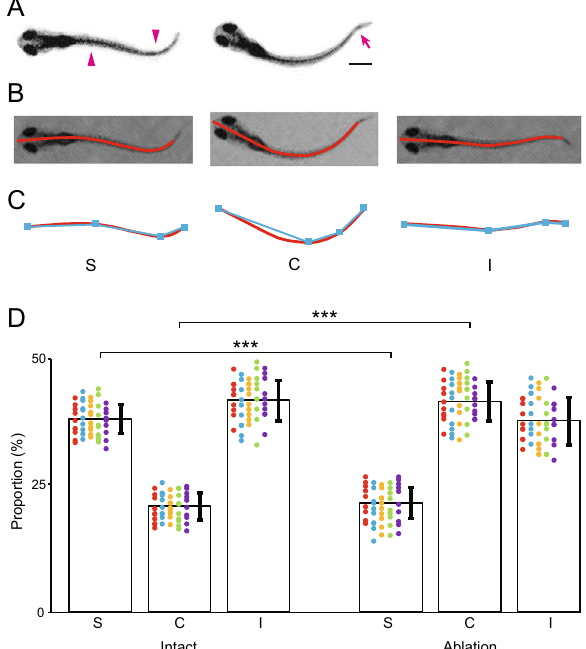
Figure 5. S-shape swim forms are impaired in MCoD-ablated fish. ( A ) Examples of typical swim forms of an intact fish (left) and an MCoD-ablated fish (right). Arrowheads in the left panel show presumed muscle- contraction sites. An arrow in the right panel shows a kinked bend near the tail tip, which is likely produced by passive force from the surrounding water. Scale bar, 500 μm. ( B ) Extractions of the skeletal line representing body shape (red lines). The left panel corresponds to the left panel of (A), and the center panel corresponds to the right panel of (A). The right panel is an image of an intact fish near the end of a swim bout. ( C ) The skeletal line in (C) is fitted to polylines (cyan lines) consisting of four vertices including head and tail termini. ( D ) Histograms of the appearance frequencies of “S”, “C”, and “I” forms in the movie frames of intact fish (left) and MCoD-ablated fish (right). *** p < 0.001 (two-tailed t